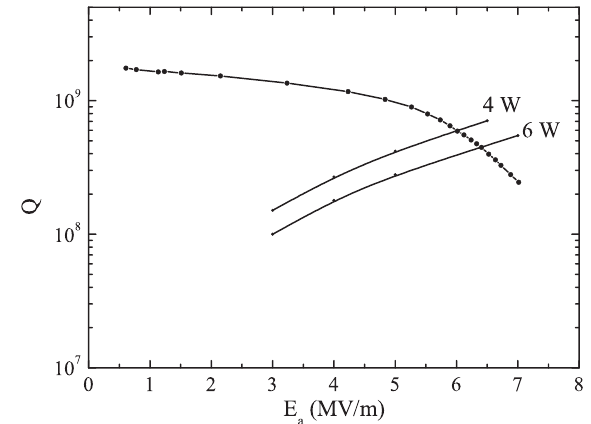
FIG. 10. Resonator Q as a function of the accelerating gradient E a at 4.2